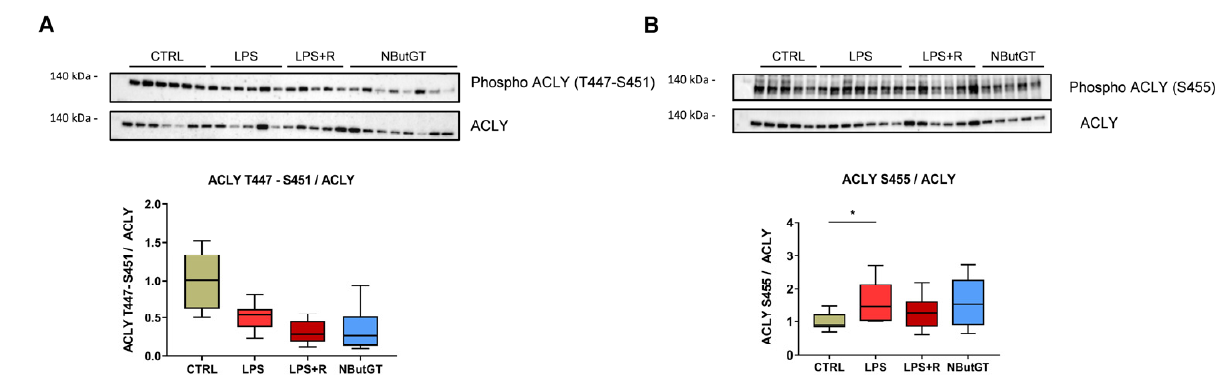
Figure 6. Impact of septic shock and NButGT treatment on ACLY phosphorylation. Evaluation by Western blot of the phosphorylation of ACLY on threonine 447, serine 451 ( A ) and serine 455 ( B ). Statistical significance was assessed by Kruskal–Wallis test with uncorrected Dunn’s post-test (*: p < 0.05). Results are expressed as mean ± SEM. CTRL: control group, LPS: i.v. injection of LPS (20 mg/kg), LPS+R: subcutaneous administration of 10 mL/kg of NaCl 0.9%, NButGT: resuscitation supplemented with NButGT (10 mg/kg). n = 5–9.